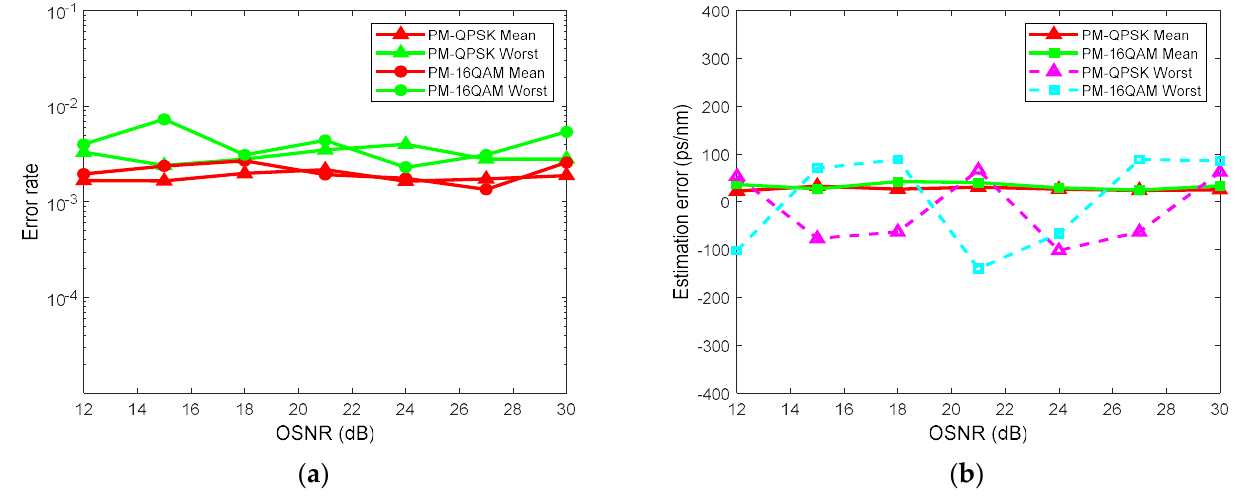
Figure 11. Relationship between ( a ) error rate and ( b ) estimation error with OSNR.